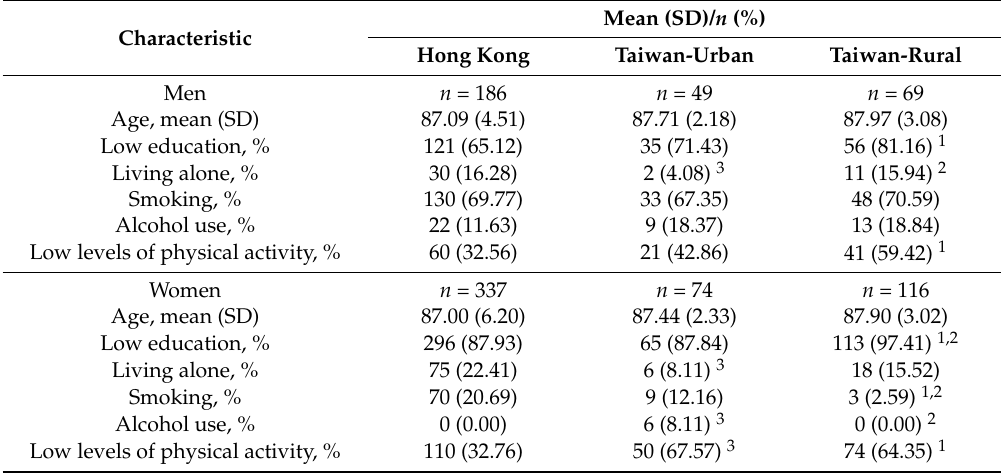
Table A4. Population characteristics between Hong Kong, Taiwan-urban and Taiwan-rural: age